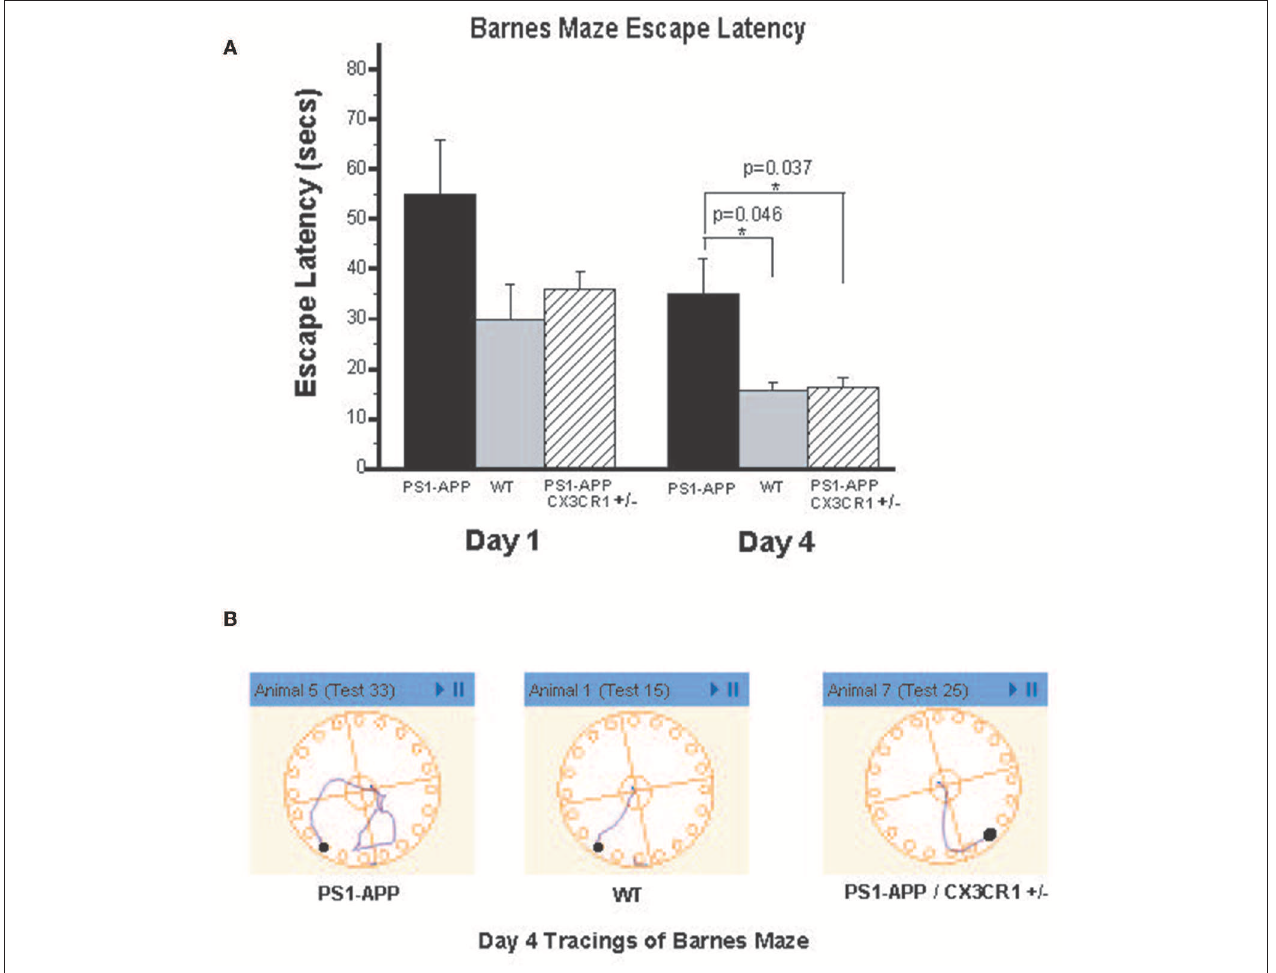
FIGURE 7 | PS1-APP-CX3CR1 + / − mice perform better that PS1-APP in the Barnes maze behavioral test. Mice at 10-months of age were first trained for 5 days on cued-target Barnes maze and then data collected during a 4-day training using hidden-fixed target protocol on Barnes maze. Escape latency, which is the time for a subject to locate and enter the escape box, was collected for each mouse during all trials and is shown in (A) for Days 1 and 4 of the hidden-fixed target Barnes maze protocol (mean escape latency in s ± SEM). On Day 1 there were no significant differences in escape latencies between genotypes. By Day 4, PS1-APP animals took significantly longer to escape the maze compared with both WT and PS1-APP-CX3CR1 + / − mice. (B) Shows representative maze tracings for each genotype on Day 4 of the hidden-fixed target protocol. Animal numbers are WT ( n = 6), PS1-APP ( n = 8) and PS1-APP-CX3CR1 + / − ( n = 6). * represent statistically